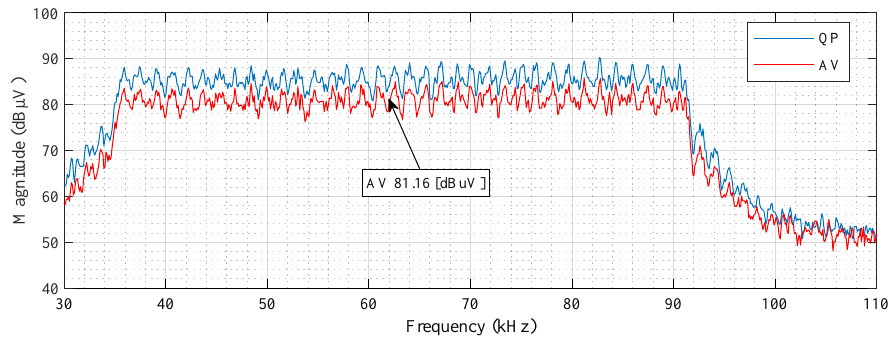
Figure 5. The spectrum of the G3 signal for PLC.